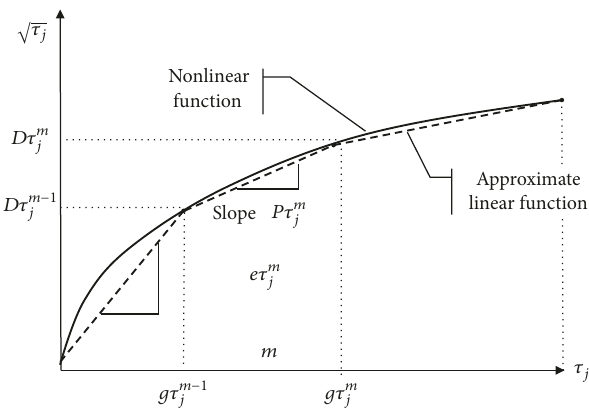
Figure 3: Piecewise linear function PLF of WIC